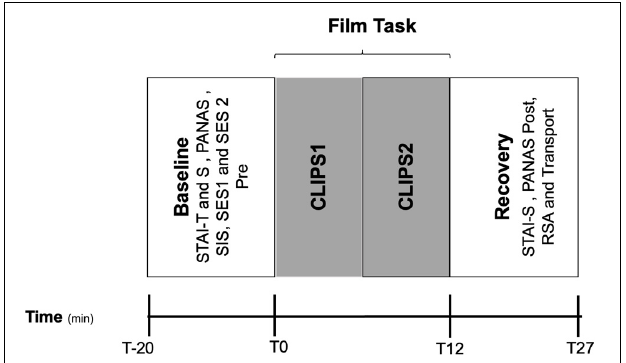
FIGURE 1 | Different phases of the experimental protocol. Sequential salivary cortisol sampling (t-20 to